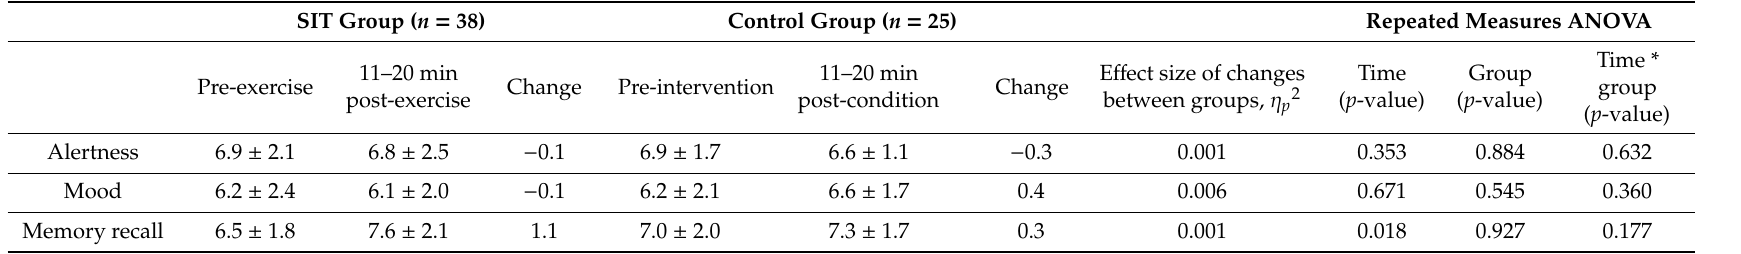
Table 1. Mean ± SD of alertness, mood, and memory recall of female primary school children.